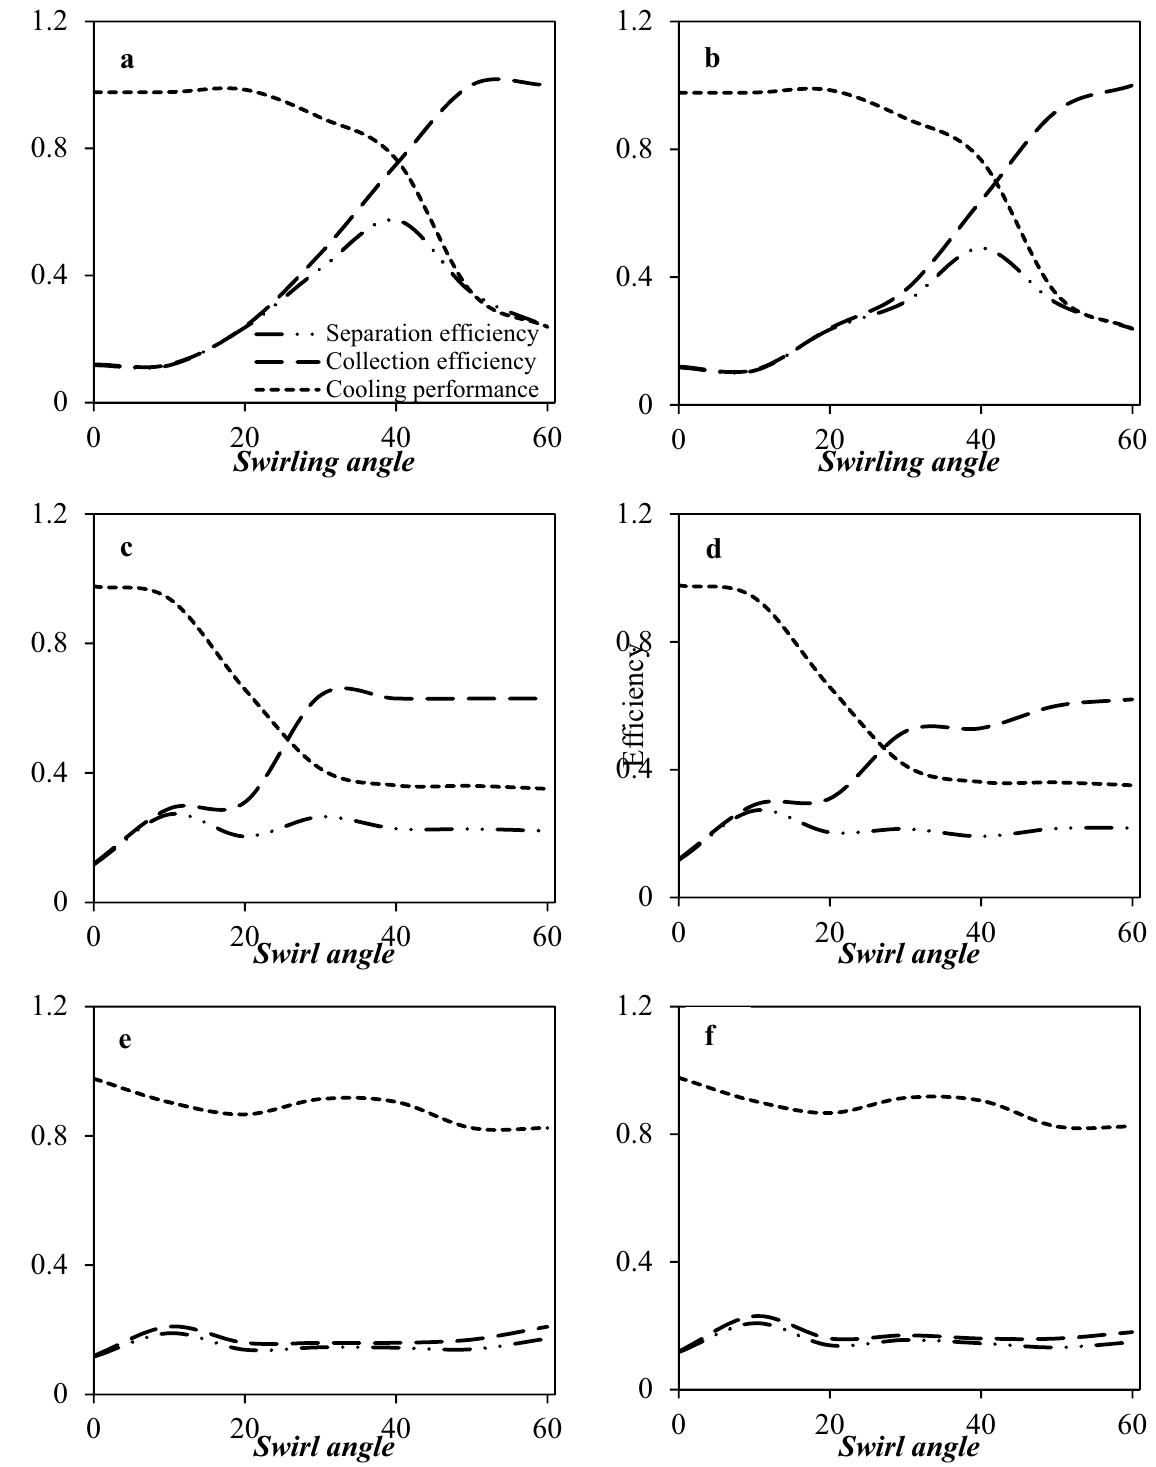
Figure 9. The influence of swirl angle on the collection efficiency, cooling performance and separation efficiency of 3S quipped with axial swirler ( a , b ), wall mounted swirler ( c , d ) and helical swirler ( e , f ) for water ( a , c , e ) and HC droplets ( b , d , f